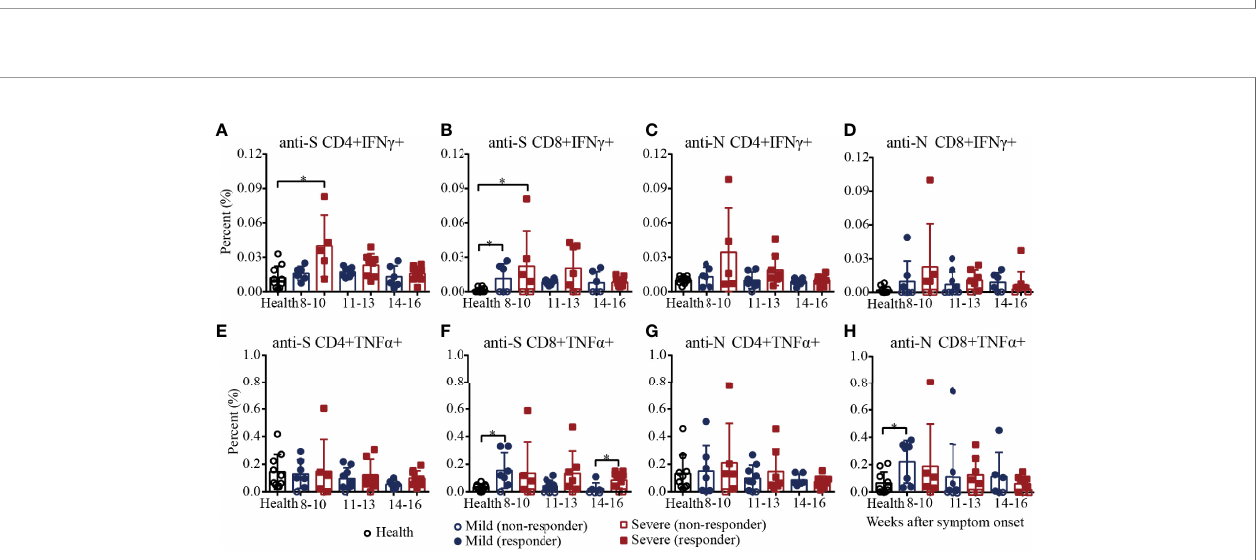
FIGURE 5 | T-cell responses to SARS-CoV-2 in recovered COVID-19 patients measured by fl ow cytometric analysis. Comparison of the IFN g responses against the CD4 + (A) or CD8 + (B) S protein peptide pool or the CD4 + (C) or CD8 + (D) N protein peptide pool between the mild and severe patients. Comparison of the TNF a responses against the CD4 + (E) or CD8 + (F) S protein peptide pool or the CD4 + (G) or CD8 + (H) N protein peptide pool between the mild and severe patients.